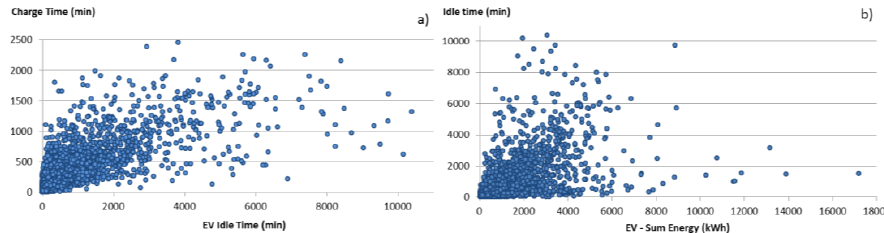
Figure 9. Relation between the sum of EV idle time and charge time ( a ) and total energy drawn with corresponding idle time sum ( b ) both per vehicle.